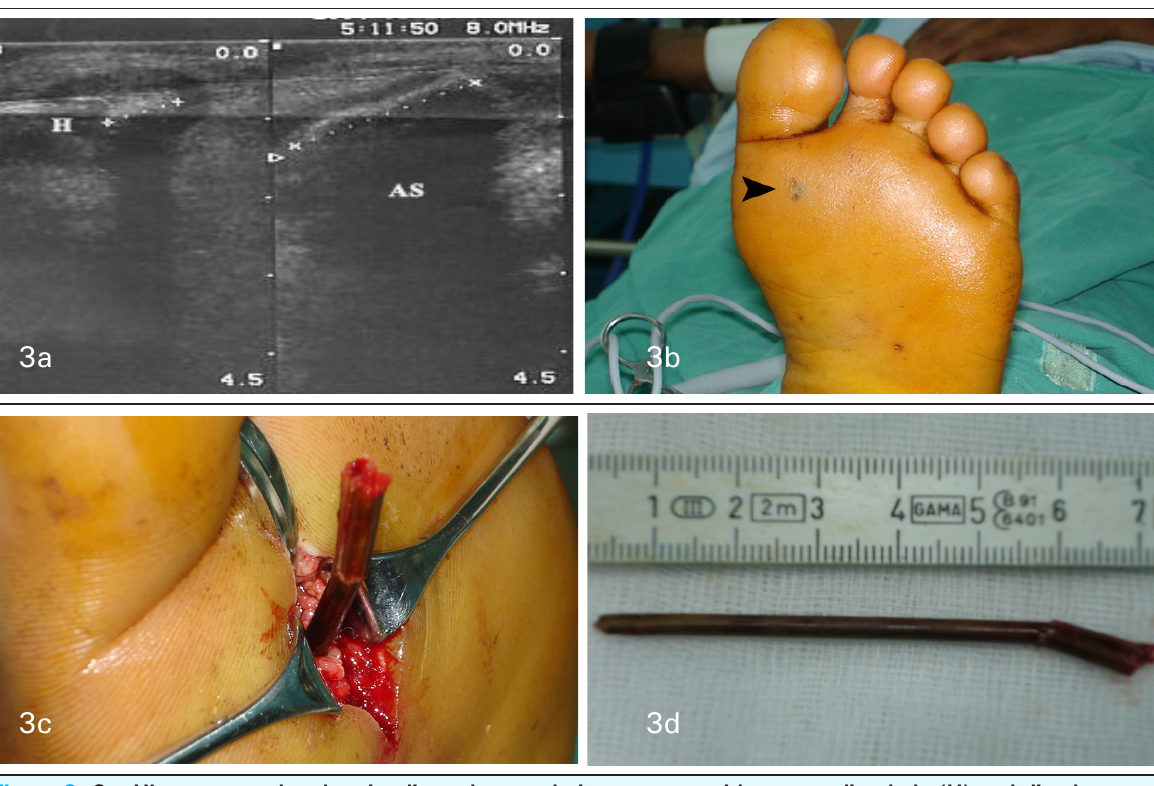
figure 3. 3a. Ultrasonography showing linear hyperechoic structure with surrounding halo (H) and distal acoustic shadow (As) 3b. Induration with black discoloration (arrow head) at prick injury site 3c, 3d. bamboo twig removed from planter aspect of